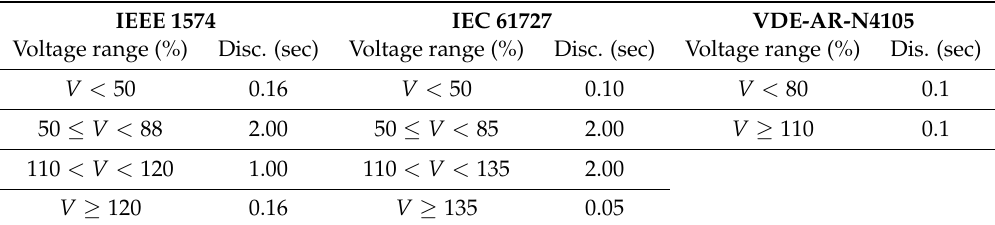
Table A1. Comparison of voltage requirements standards for LV PV systems.